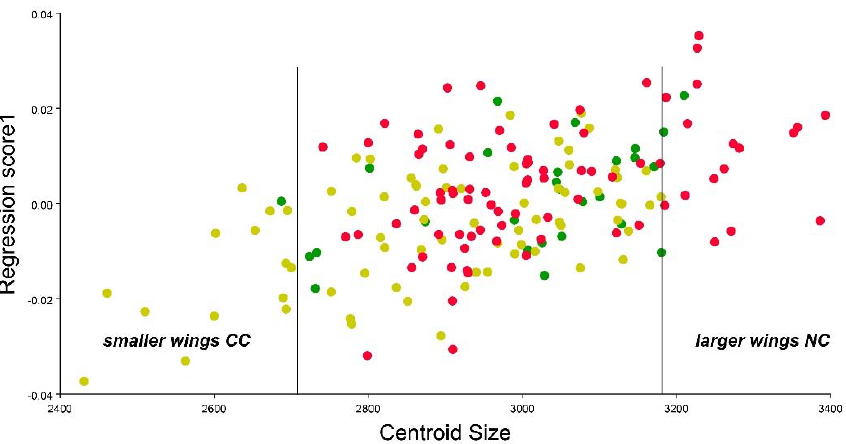
Figure 7. Multivariate regression of shape as a dependent variable vs. centroid size as an independent variable of Colorado potato beetle hindwing. CC: yellow, central Croatia; NC: red, north Croatia; EC: green, east Croatia.